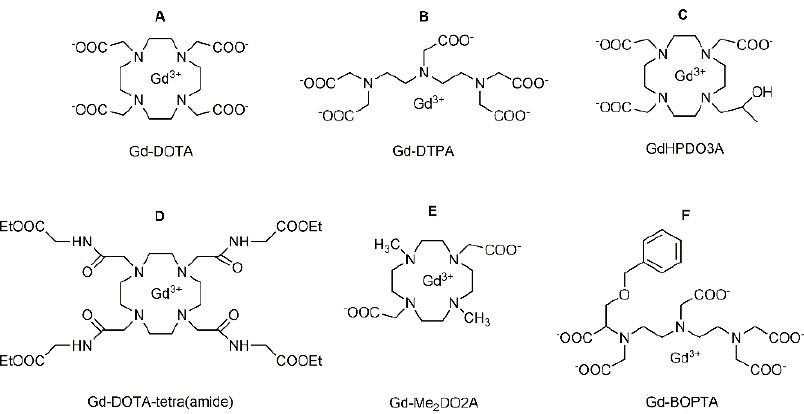
Figure 2. Chemical structures of Gd-based MRI contrast agents (CAs): ( A ) Gd-DOTA, ( B ) Gd-DTPA, ( C ) Gd-HPDO3A, ( D ) Gd-DOTA-tetra(amide), ( E ) Gd-Me 2 DO2A and ( F ) Gd-BOPTA. Different strategies for trapping small molecules in the apoferritin core were reported [29].